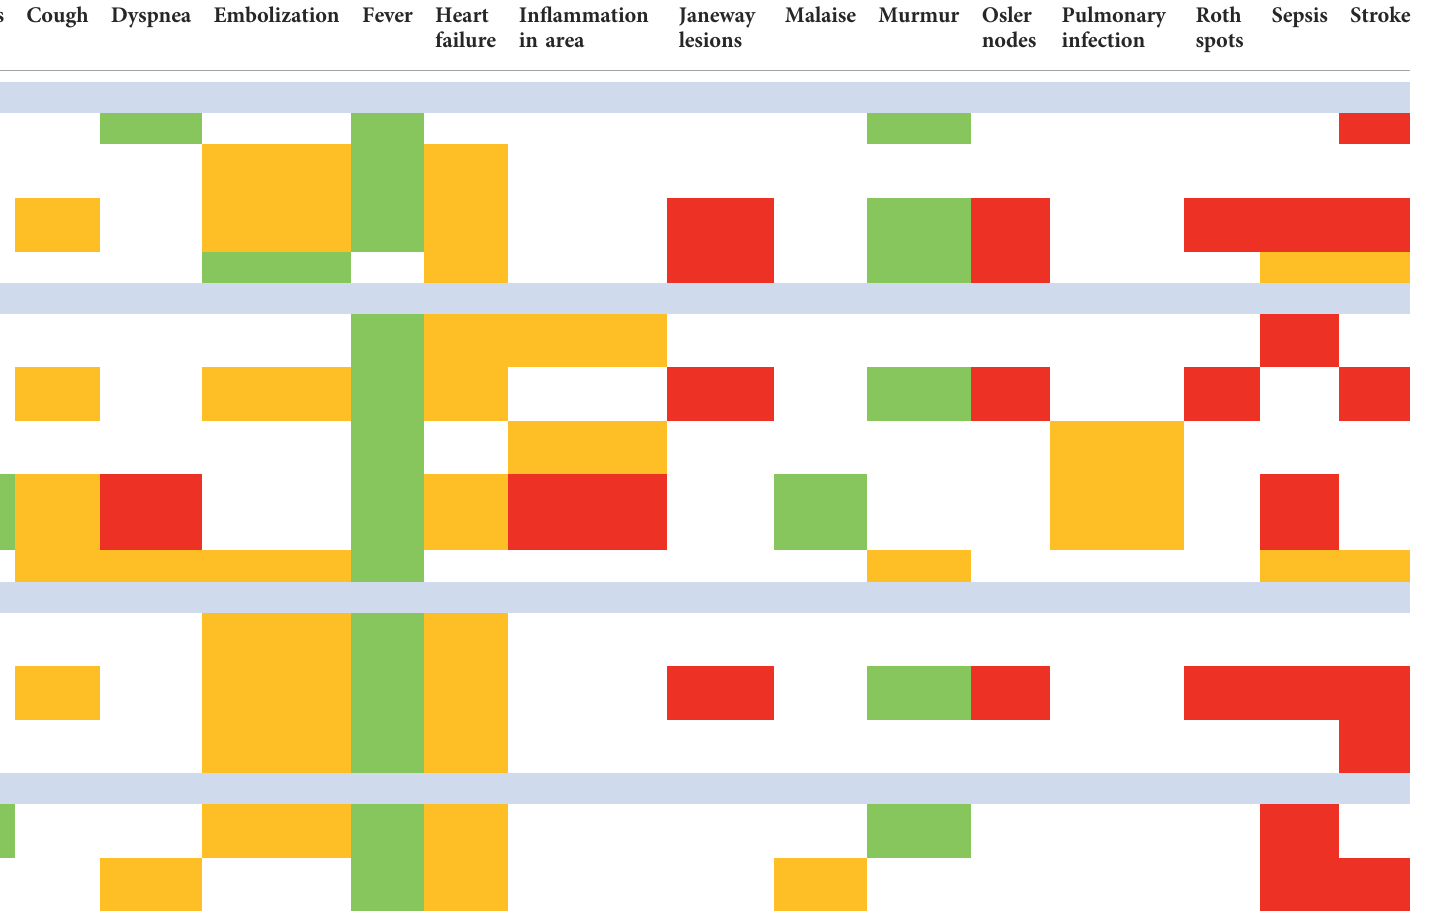
TABLE 1 Presenting symptoms in